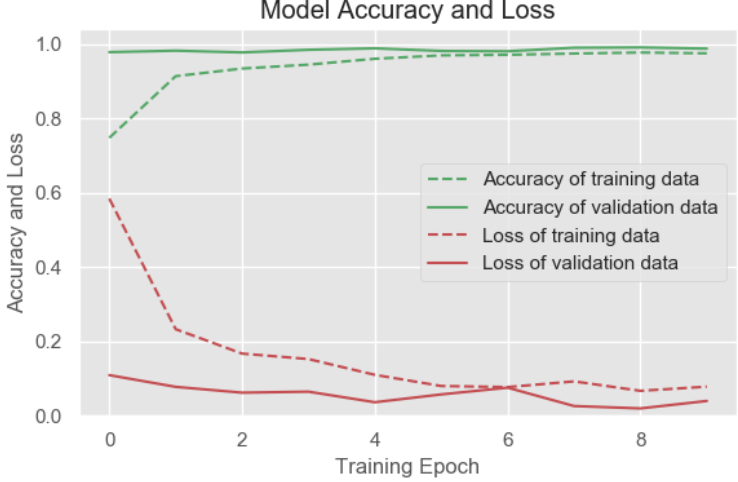
Figure 12. Sideways walking.